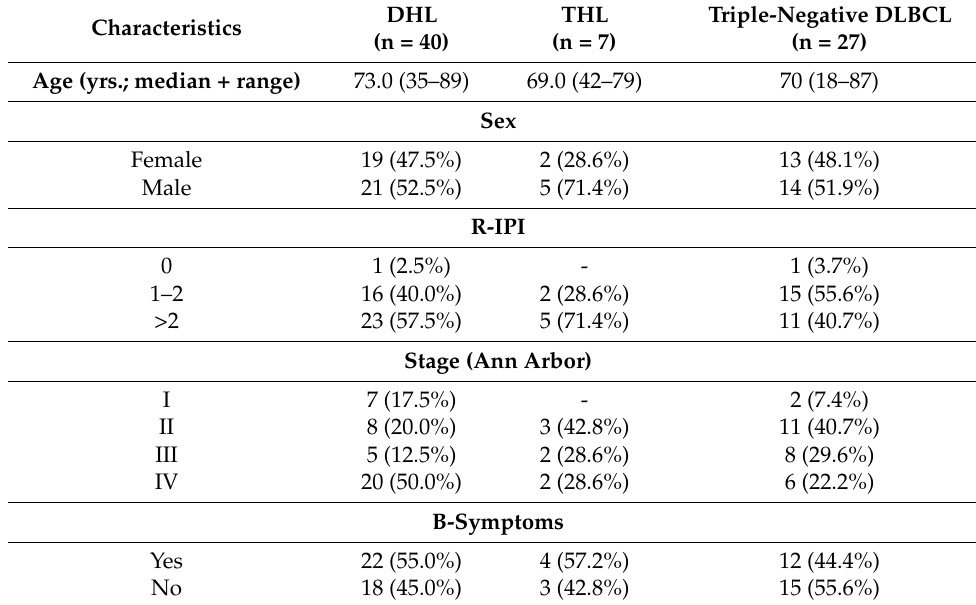
Table 1. Clinical characteristics of the study